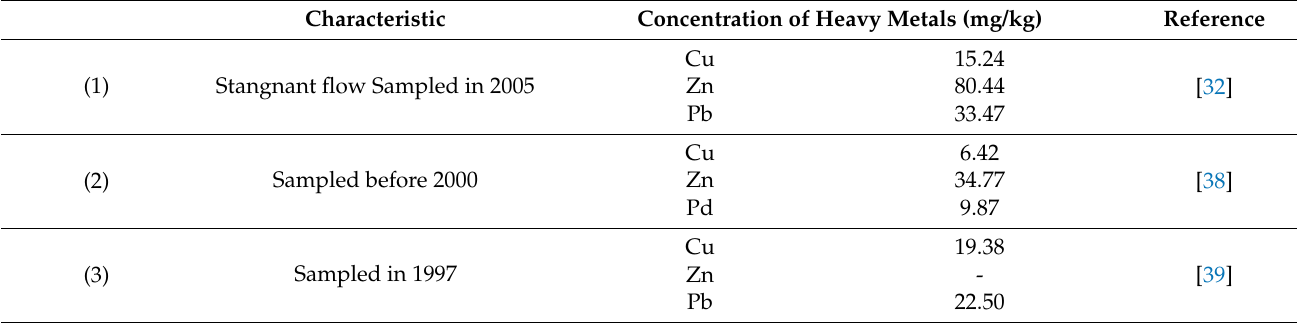
Table 3. Concentration of the heavy Metals before the dam construction.